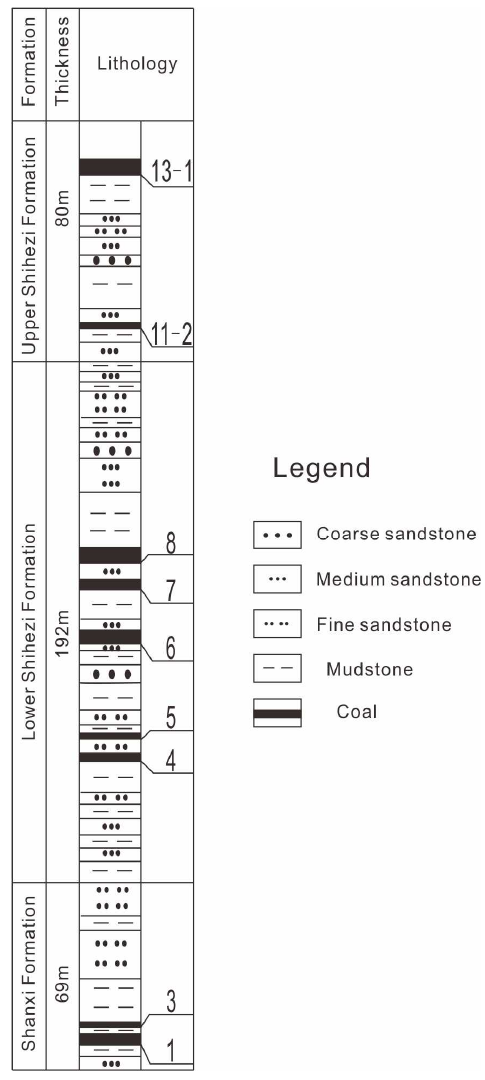
Figure 2. Generalized stratigraphic column of the Permian coal in the Pan1 mine of the Huainan Figure2. coalfield.